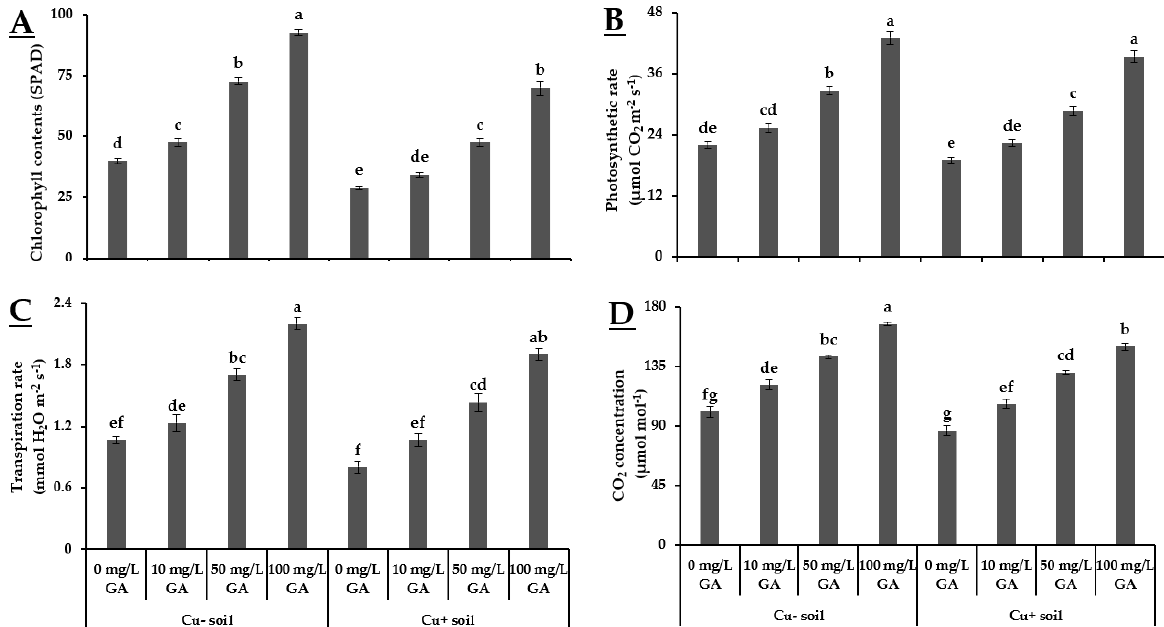
Figure 1. Effect of GA 3 application on physiological variables of pea grown in Cu+ and Cu − soil. ( A ) Chlorophyll contents; ( B ) Photosynthetic rate; ( C ) Transpiration rate; ( D ) CO 2 concentration. Different letters indicate significant difference among treatment means according to Tukey’s honestly significant difference (HSD) test ( p ≤ 0.05). Vertical bars indicate mean ± standard error ( n = 4, 5 plants per replicate under bi-factorial CRD arrangement).